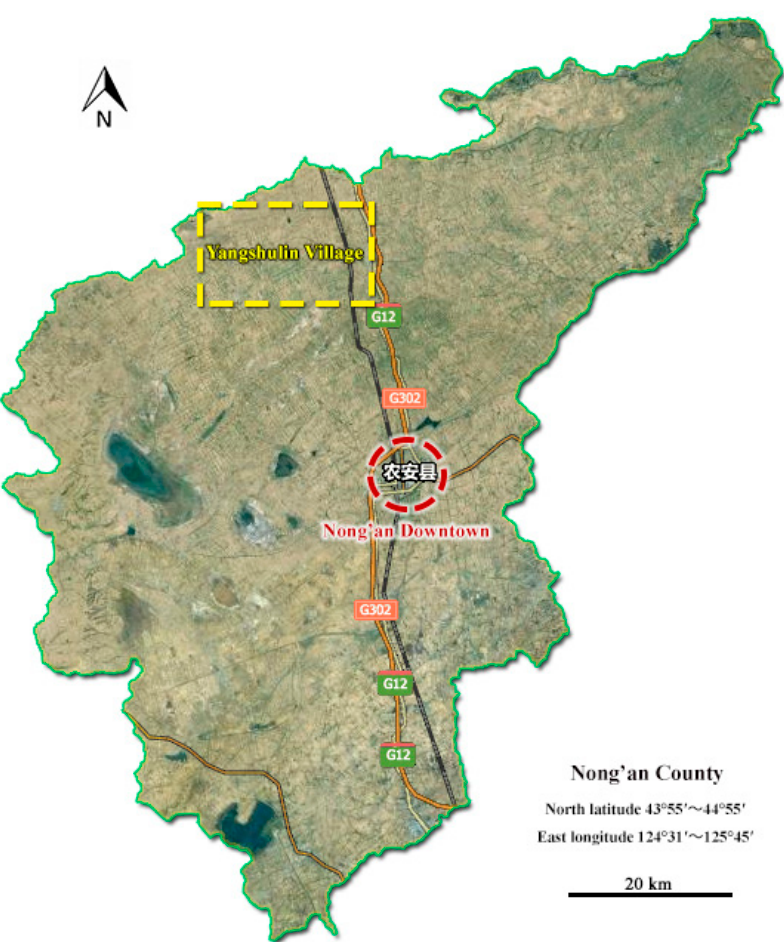
Figure 2. Geological location of Nong’an Country, Jilin Province.